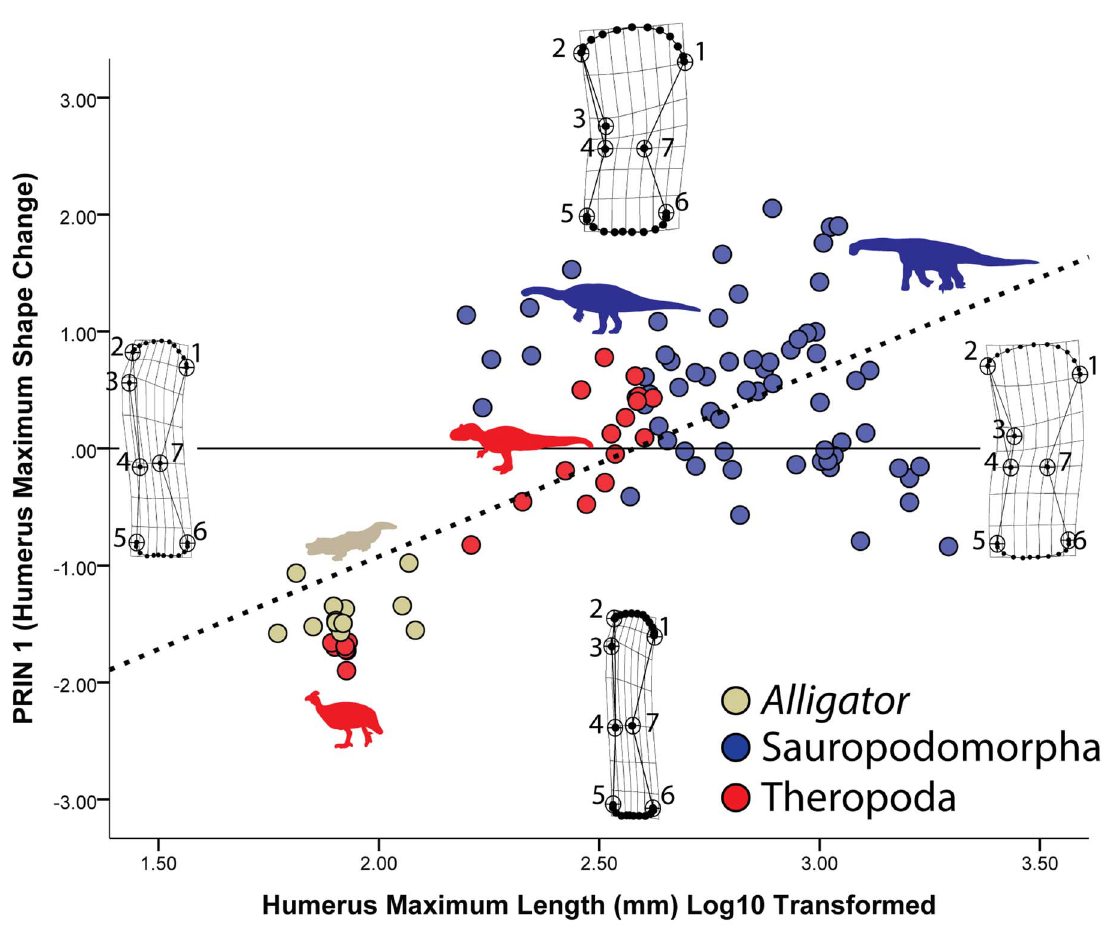
Figure 5. Changes humerus shape in saurischian dinosaurs and alligators. Maximum humerus shape change in the sample is shown on the Y-axis (PRIN 1), whereas humerus shape changes associated with size are shown on the X-axis. Changes in humerus shape along the PRIN 1 axis and X-axis are similar in that larger taxa have more proximally and distally expanded ends. In particular, the sub-articular region expands tremendously whereas its overall shape remains gently convex. Note also that the deltopectoral crest (landmarks 2–4) remains or becomes more medially-deflected as size increases.